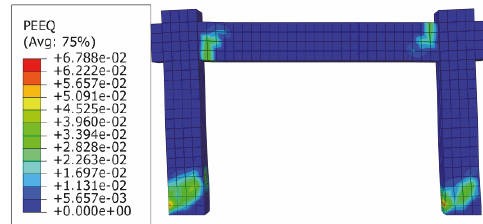
Figure 19: Plastic strain in bare frame.